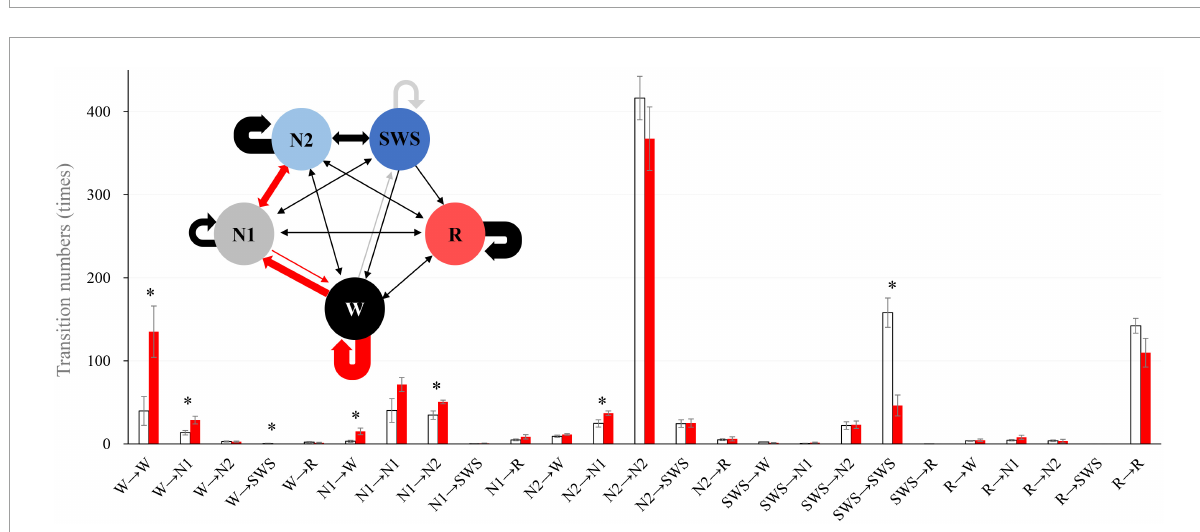
FIGURE3 Intra-stage transition numbers and transition probability. Stage transition numbers and diagram during the 8-h experiment night. The young group is shown in white, and the older group in red in the bar graph. Asterisks represent statistically significant differences between older and young groups ( p < 0.05). In the diagram, the thickness of the arrows indicates the number of transitions (bold line: > 100, semi-bold line: > 20, thin line ≤ 20; red and gray arrows indicate statistical significance (red: older > young, and gray: young > older). The I-bar shows